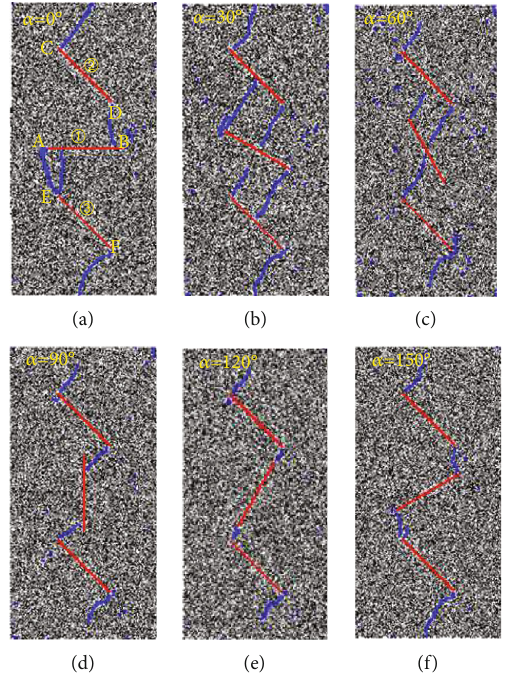
Figure 11: Initial crack propagation of the specimens containing three precracks.